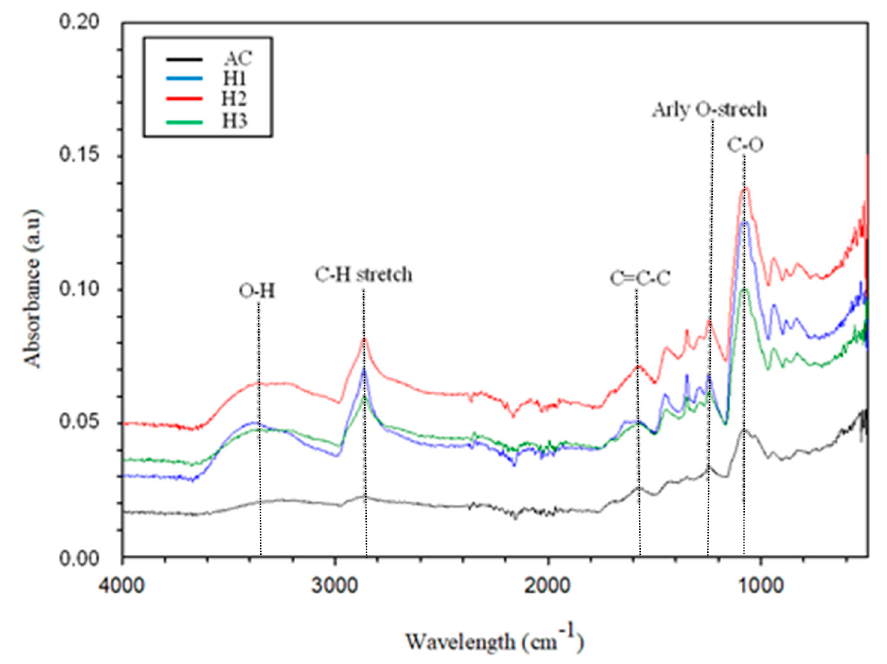
Figure 3. FTIR spectra of adsorber membrane with Activated Carbon (AC), (H1) HCl 0,5 M; (H2) HCl 1 M; (H3) HCl 1.5 M. 1 M; (H3) HCl 1.5